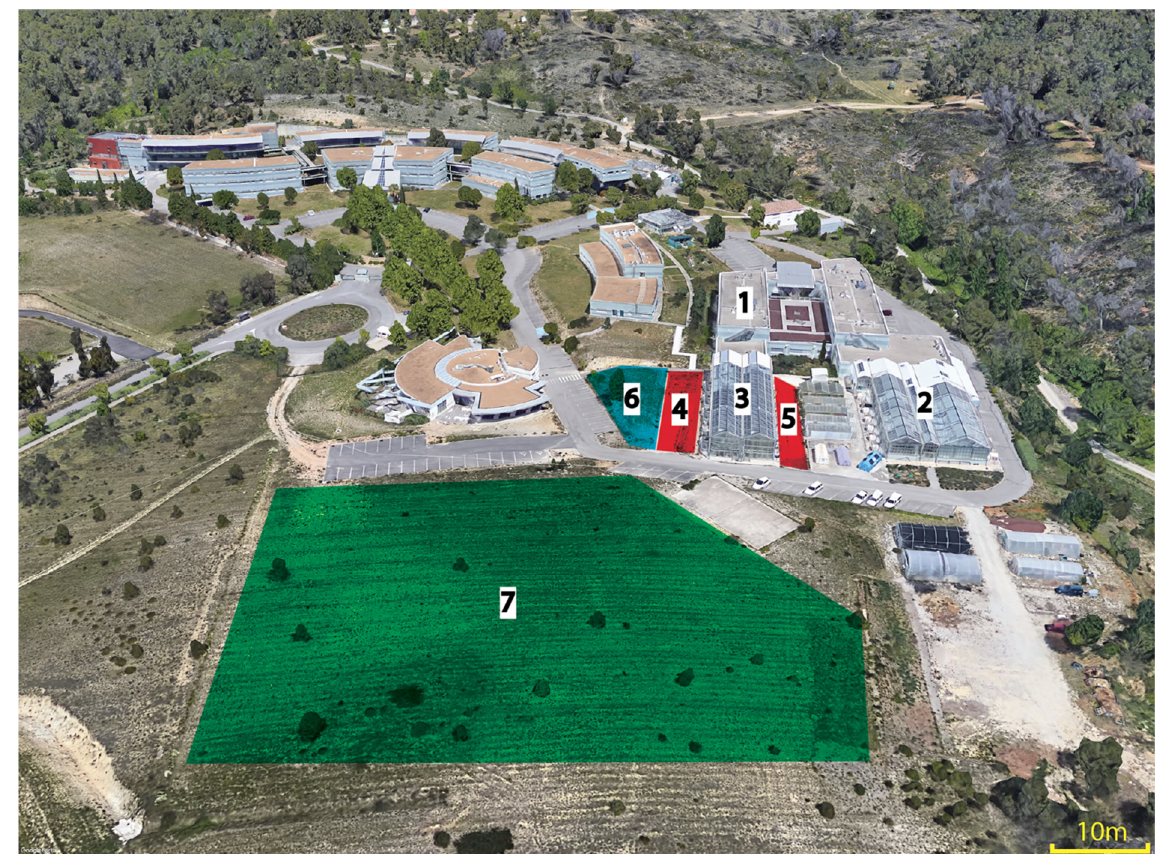
Figure 1. Aerial view of Cirad’s campus showing the sugarcane quarantine (Visacane) and the sampling locations used for analysis of the virome of Poaceae in the environment of the sugarcane quarantine facilities. 1, Research laboratories; 2, plant pathology glasshouse; 3, sugarcane quarantine glasshouse; 4 and 5, flat stone land (framed in red) adjacent to the quarantine glasshouse; 6, sloped land (framed in blue) near the quarantine glasshouse, and 7, grassland (framed in green) near the quarantine glasshouse. This image was retrieved from Google Earth.